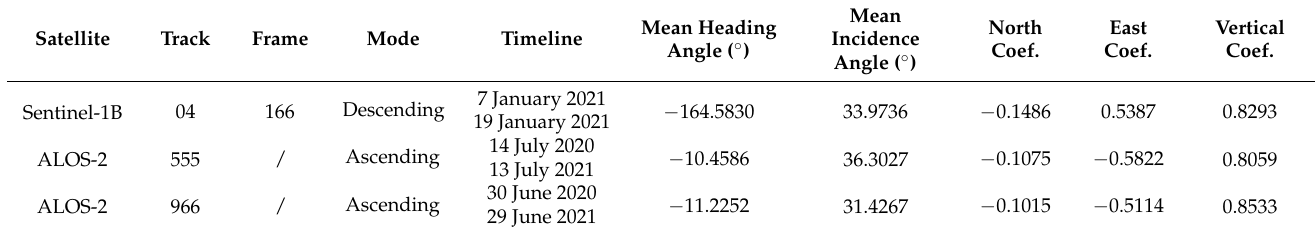
Table 2. Parameters of coseismic SAR images used for the 2021 Mw6.7